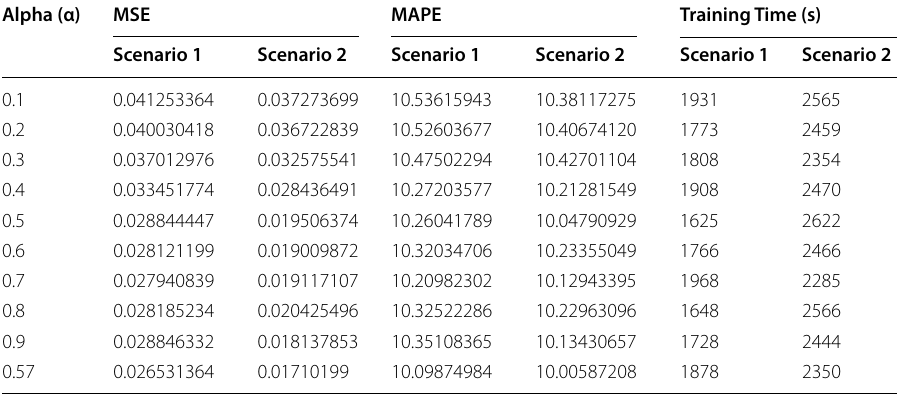
Table 8 Performance comparison using various values of smoothing factors Alpha (α) MSE MAPE Training Time (s) Scenario 1 Scenario 2 Scenario 1 Scenario 2 Scenario